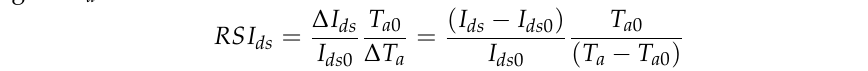
Figure 3. DC output characteristics of the studied GaN HEMT at different T a .